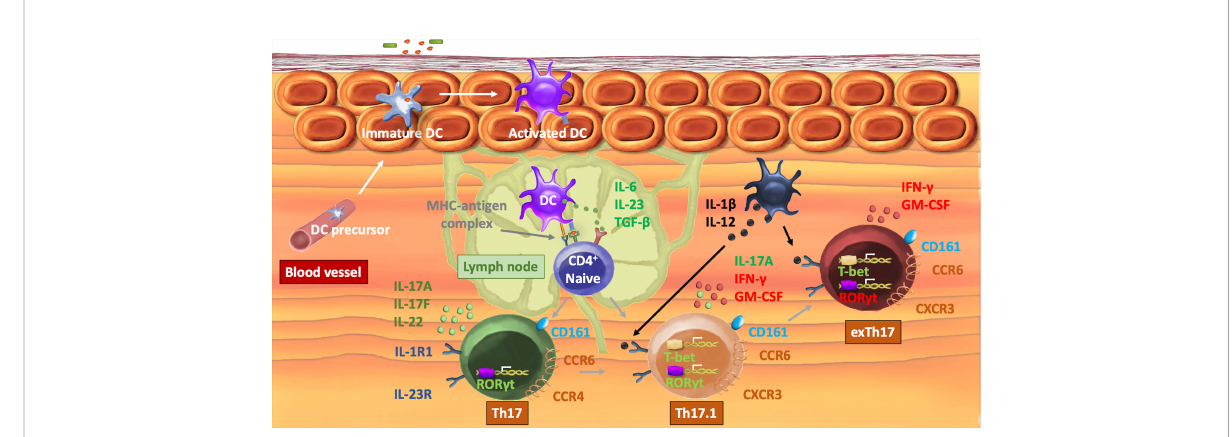
FIGURE 1 Mechanisms of Th17 plasticity. After recognition of an antigen, a DC translocates to a neighboring lymph node. Activation of a naive T-cell occurs by interaction of the MHC – antigen complex with the T-cell receptor. IL-6, IL-23, and TGF- b induce the expression of the transcription factor ROR g t that orchestrates the differentiation of the Th17 lineage and directly induces the transcription of IL-17A/F and IL-22 as well as chemokine receptors CCR4 and CCR6. In the presence of pro-in fl ammatory cytokines IL-12 and IL-1 b , T-bet is expressed, which enables transdifferentiation into a Th17.1 cell subset, characterized by the production of both IL-17 and IFN- g as well as the expression of CXCR3. In speci fi c circumstances, Th17 loses the capacity to produce IL-17 and becomes exTh17 cells. Th17, t-helper 17; DC, dendritic cell; CD, cluster of differentiation; MHC, major histocompatibility complex; IL, interleukin; TGF- b , transforming growth factor b ; ROR g t, retinoic acid receptor- related orphan nuclear receptor ɣ t; C(X)CR, C(X)C chemokine receptor; T-bet, T-box protein expressed in T